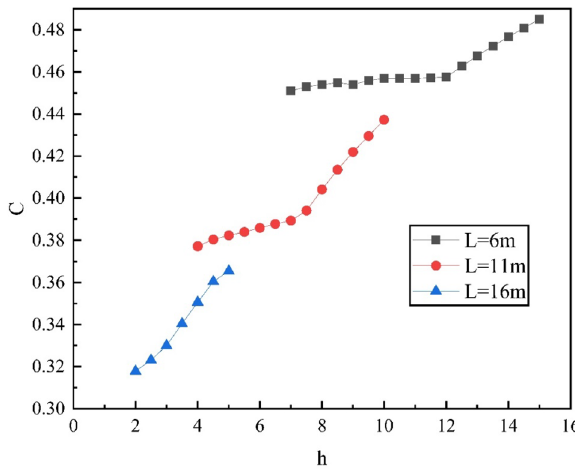
Figure 8. Variation of C with h in different liquid height control